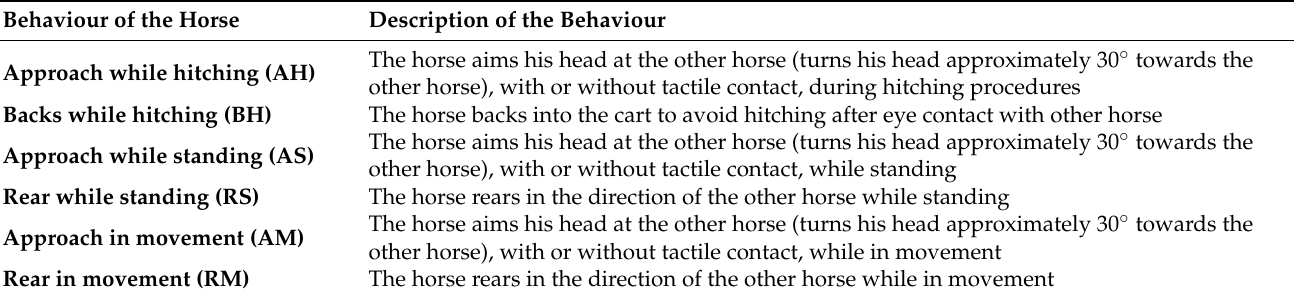
Table 3. Descriptions of stallion interactions highlighted in bold assessed during the test